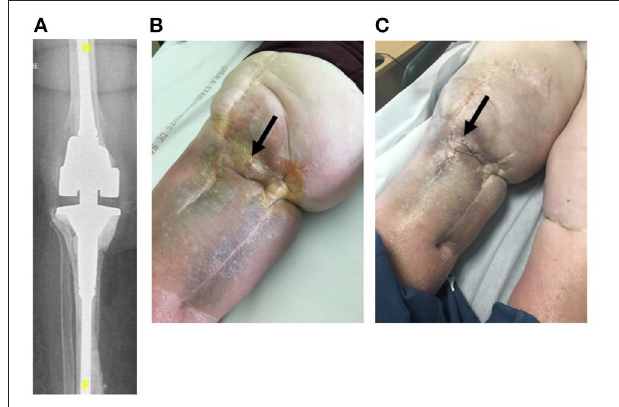
FIGURE 3 | Patient 3 was an 88-year-old woman with a current history of active chronic myeloid leukemia under imatinib therapy requiring iterative blood perfusions. She also had chronic kidney disease with indication of dialysis that the patient refused. She also had chronic lymphoedema. She had a right-cemented revision prosthesis (A) following a two-stage exchange for PKI due to MDR S. epidermidis (04/02/2011). Unfortunately, S. epidermidis persistence was diagnosed (6/7/2018), and a sinus tract occurred (B) . Cotrimoxazole as SAT was contraindicated due to the kidney disease. The patient received intermittent antimicrobial therapy with pristinamycin when skin and soft tissue inflammation occurred around the sinus tract (B) . She was treated according to the LysinDAIR procedure (10/01/2019). She received daptomycin intravenously and linezolid orally and experienced severe thrombopenia (30 G/L) leading to discontinuation of linezolid and a switch to tedizolid. Unfortunately, at 6 months, under tedizolid therapy, a new discharge occurred trough the sinus tract (C)